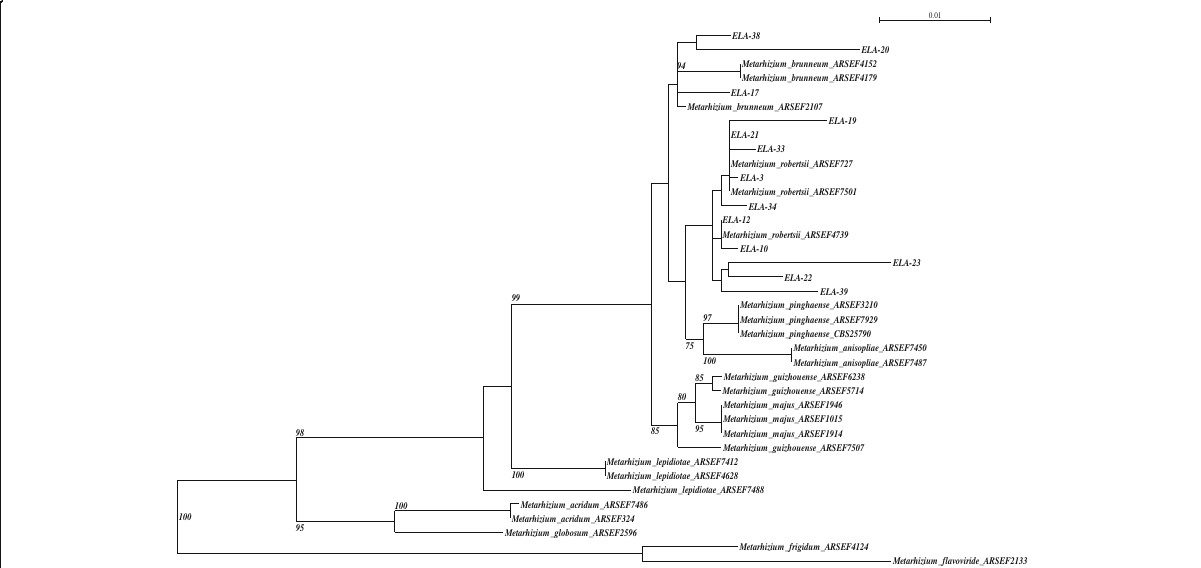
Fig. 2 Phylogenetic tree derived from maximum likelihood (ML) analysis of β -tubulin gene sequences belonging to the Metarhizium isolates and their closely related species indicated in the study of Bischoff et al. (2009). Bootstrap values based on 1000 replicates were indicated above nodes. Bootstrap values C ≥ 70 are labeled. The scale on the top of the phylogram indicates the degree of